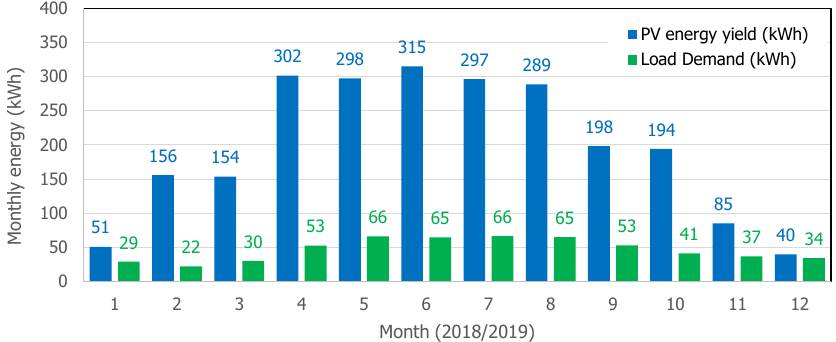
Figure 14. Monthly energy yield (in kWh) of the 2.6 kW PV system for the period of October 2018 to September 2019 and the corresponding load demand including losses (in